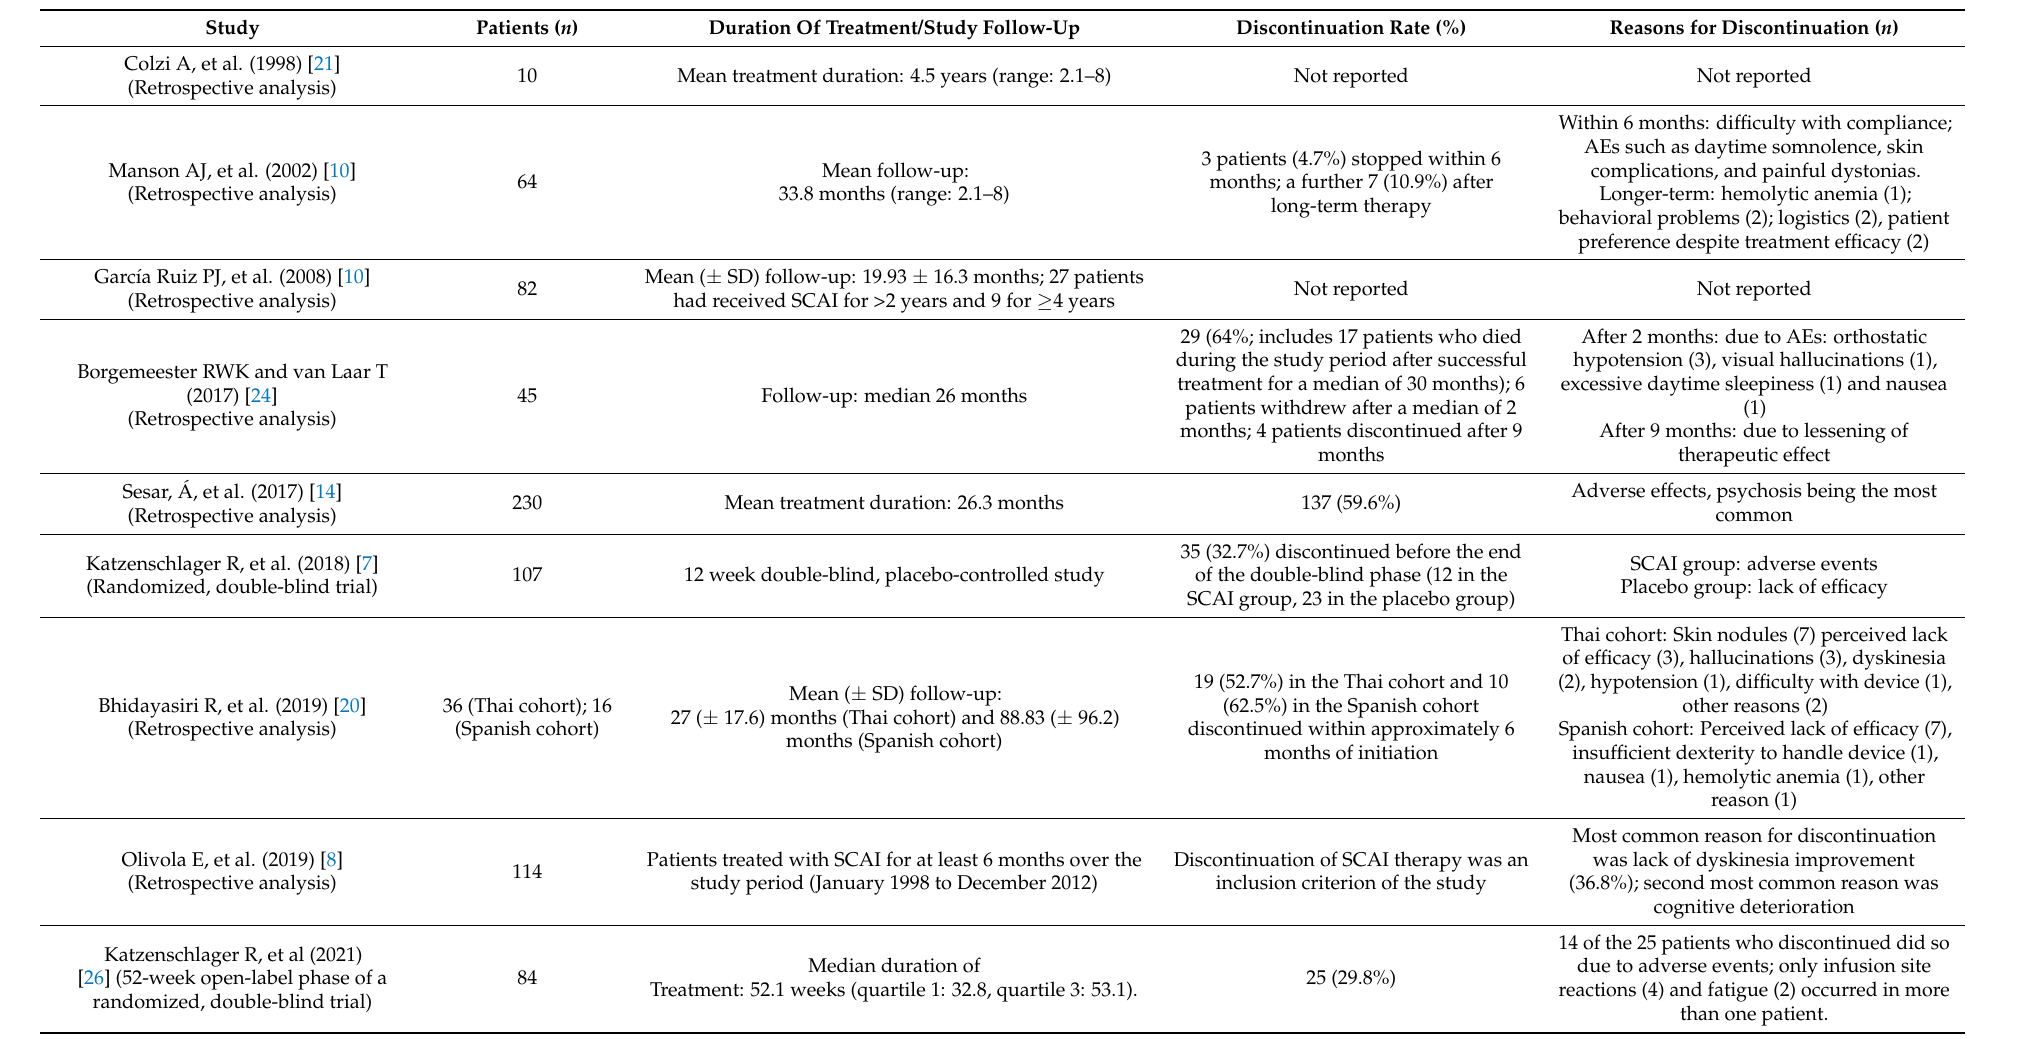
Table 2. Comparison of SCAI treatment duration and discontinuation rates from published